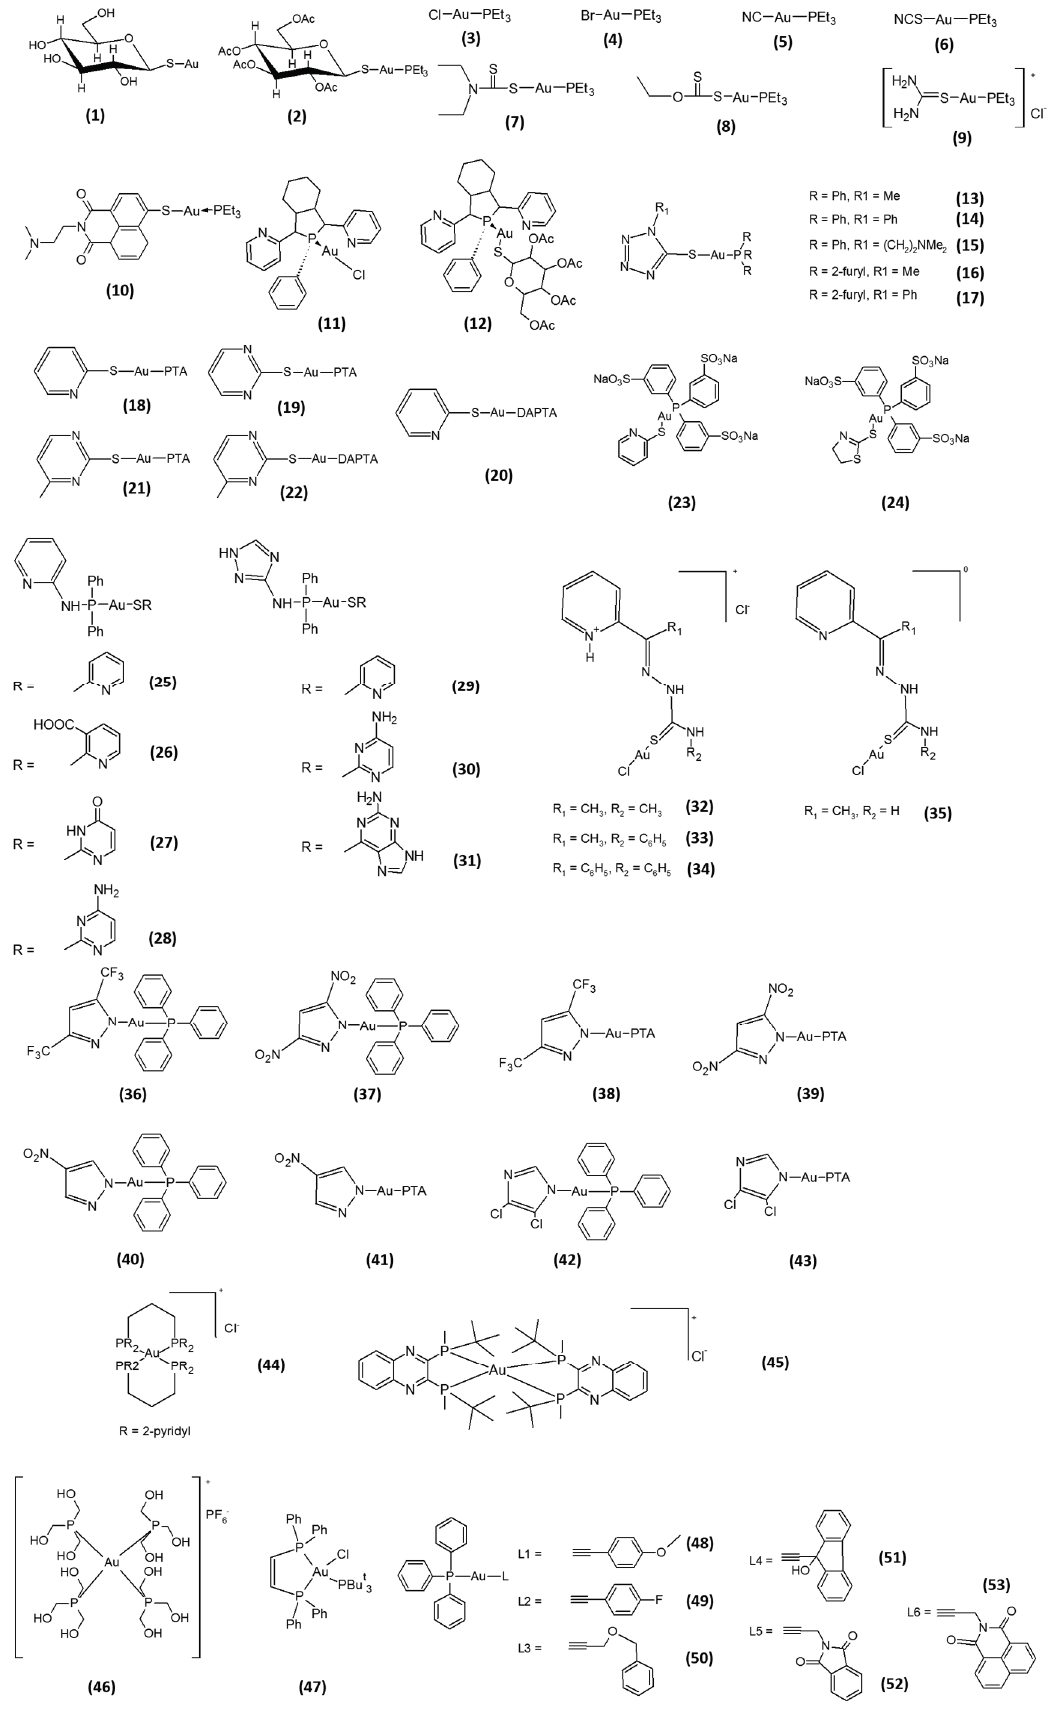
Figure 2. Structures of phosphine gold(I)-based